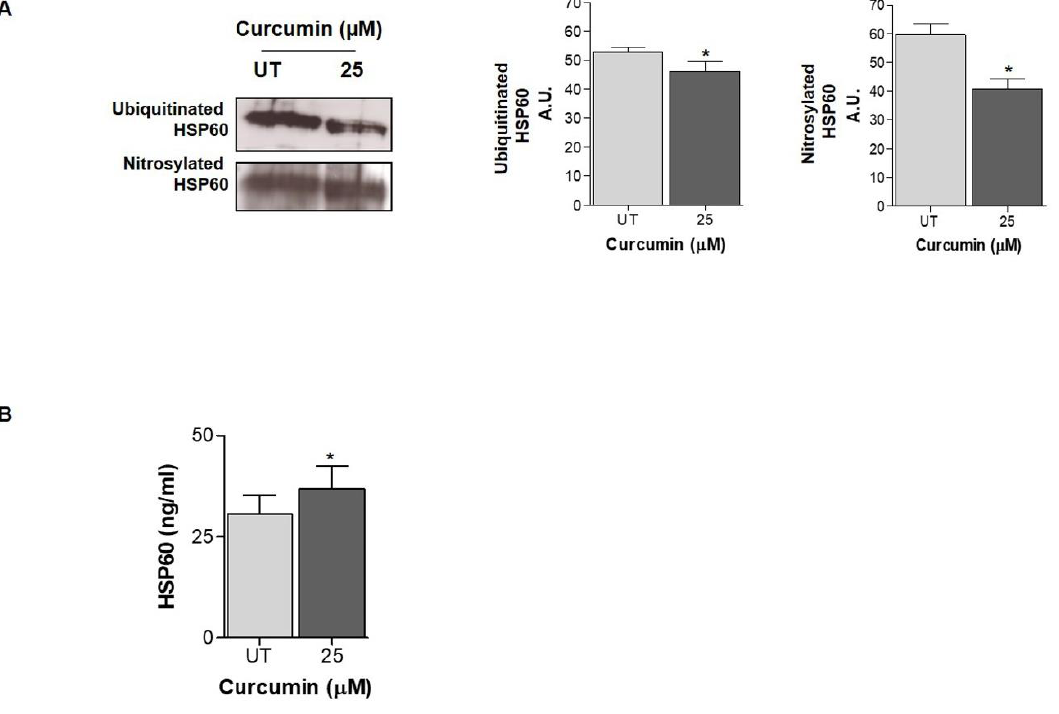
Figure 3. Effects of curcumin treatment on HSP60 post-translational modification and localization ( A ) 25 µM of curcumin does not promote HSP60 ubiquitination and nitrosylation after 24 h of treatment. ( B ) HSP60 levels in cells supernatant, detected by enzyme-linked immunoadsorbent assay (ELISA). The difference between HSP60 levels in cells supernatant after 24 h of treatment (25 µM of curcumin) versus untreated cells was significant (* p < 0.001).